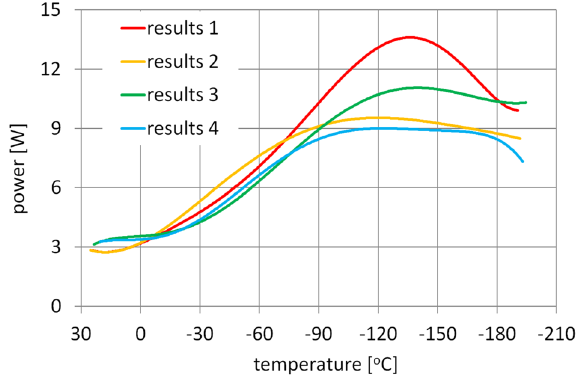
Figure 14. Trend lines of the measurements of the gearbox power losses.